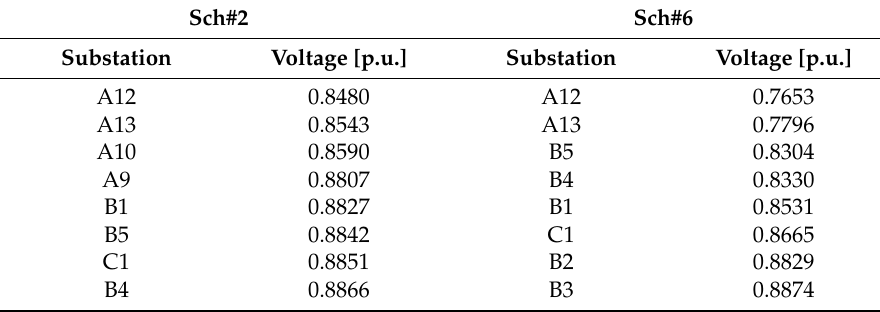
Table 12. Under-voltage